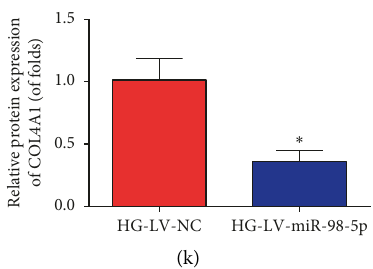
Figure 5: Overexpression of miR-98-5p alleviated high glucose-induced cell proliferation, EMT, and renal fibrosis in cultured mice mesangial cells. (a) Real-time qPCR analysis showing miR-98-5p expression in mice mesangial cells treated with high glucose (HG, 25mM) as compared with the cells treated with normal glucose (NG, 5.6 mM). (b) Real-time qPCR analysis showing miR-98-5p expression in mice mesangial cells infected with LV-miR-98. (c) Result of CCK-8 assay in mouse mesangial cells. (d and e) Result of EDU assay in mouse mesangial cells. Western blot images of E-cadherin and N-cadherin (f). Quantification of the western blot images of E-cadherin and N- cadherin (g and h). The western blot images of TGF- β 1 and COL4A1 (i). Quantification of the western blot images of TGF- β 1 (j) and COL4A1 (k). n 8 for each group. Data are representative of three experiments. Error bars stand for the mean (cid:31)